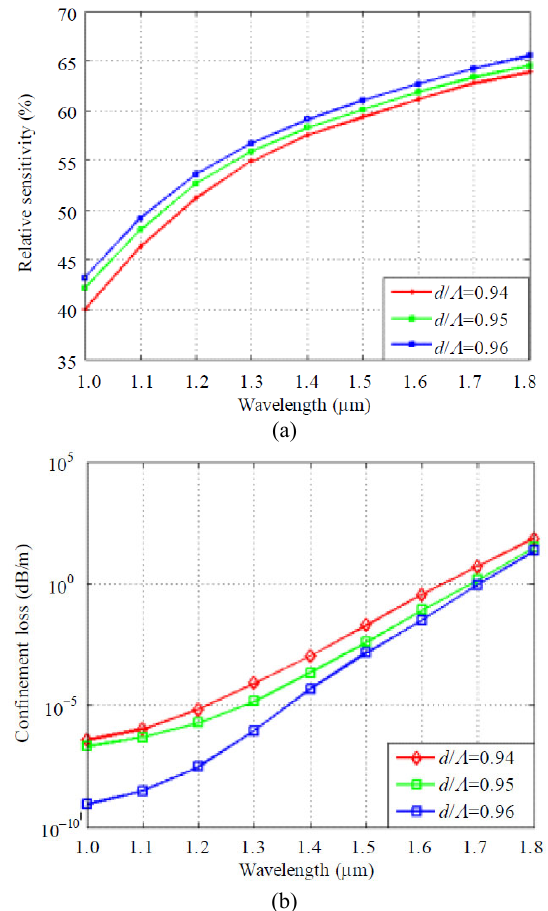
Fig. 4 Comparison between: (a) relative sensitivity versus wavelength and (b) confinement loss versus wavelength curve of the proposed H-PCF for optimized parameters:  = 3.00 